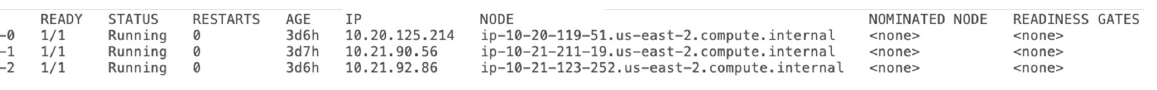
Figure 15. RabbitMQ deployed with the proposed solution.